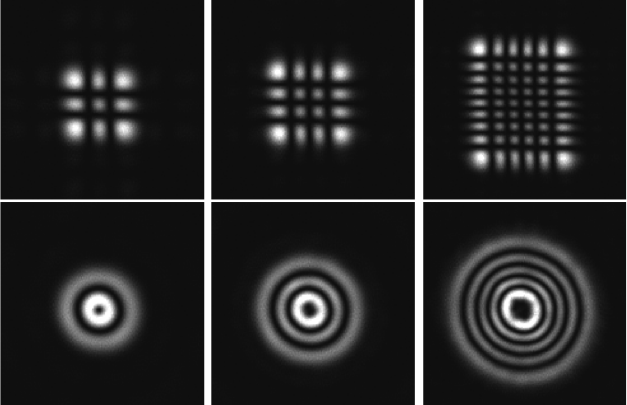
Fig. 9. Experimental restitution of HG and LG modes. They respectively correspond to the modes HG 2 , 2 , HG 3 , 3 , HG 5 , 8 (top) and LG 1 , 1 , LG 2 , 2 , LG 4 , 4 (bottom), from left to right.